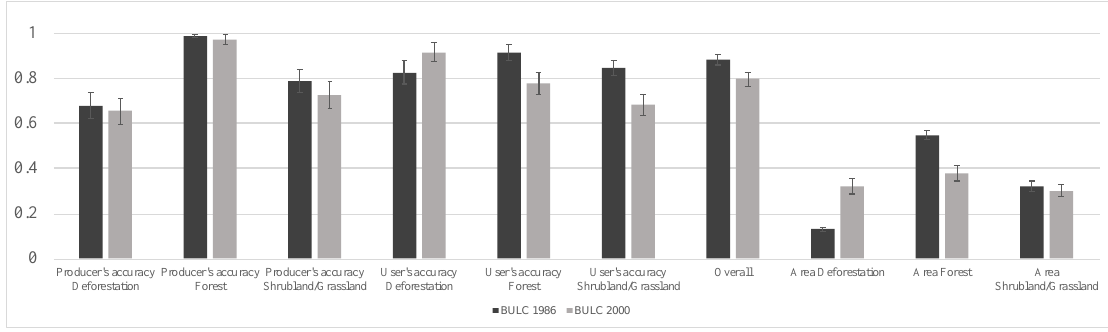
Figure 7. Accuracy assessment (unbiased) of BULC-U 1986 and BULC-U 2000 within the study area. Protocol following Stehman (2014).